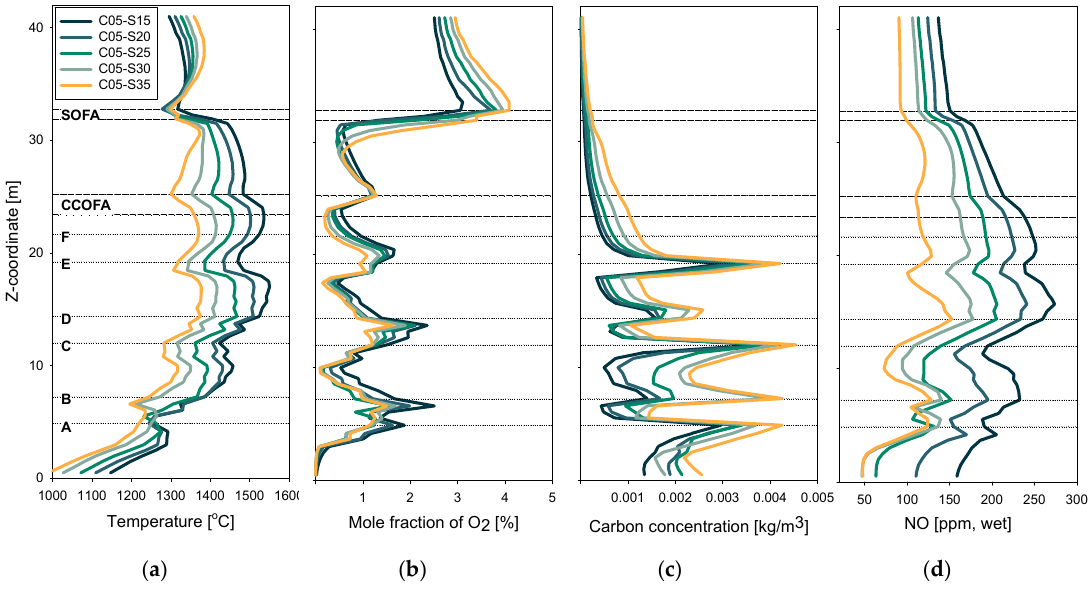
Figure 7. Mass-weighted average profiles of gas temperature and concentrations of O 2 , solid carbon, and NO in the burner zone for different SOFA ratios (CCOFA ratio fixed at 5%). ( a ) Temperature; ( b ) O 2 ; ( c ) Solid carbon and ( d ) NO.